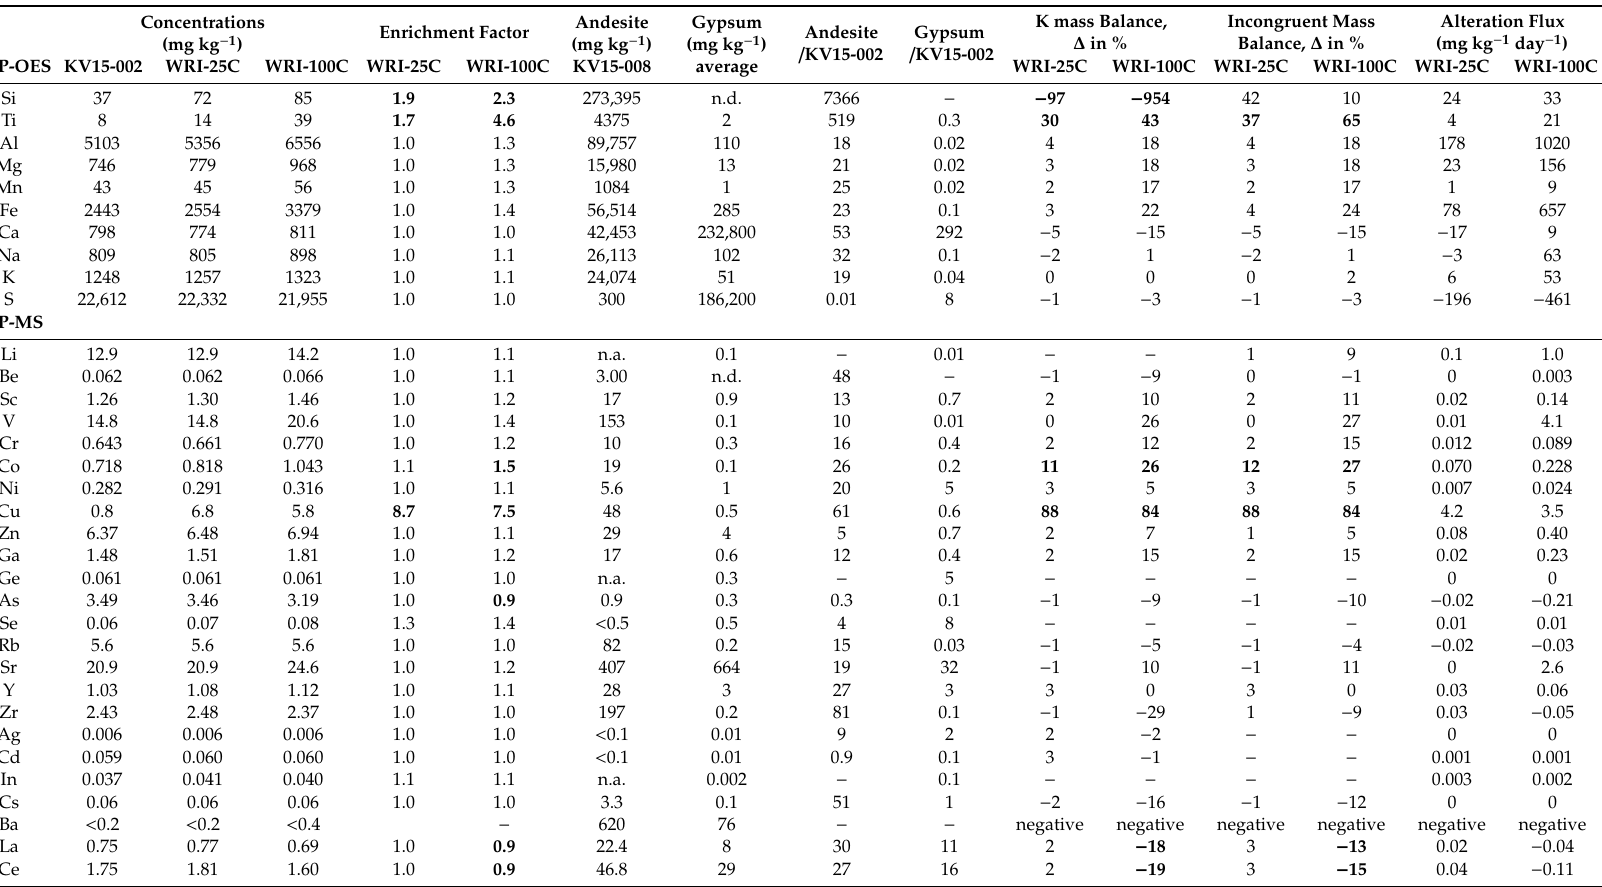
Table 2. Compositions of the starting and run product fluids as determined by ICP-OES and ICP-MS, the bulk composition of the starting andesite and the median composition of gypsum formed during Kawah Ijen quiescence (from [33]). Derived parameters include the enrichment factors of the experimental fluid, andesite and gypsum relative to the starting solution, results of mass balance calculations for congruous and incongruous andesite dissolution, and the calculated alteration mass flux (see the text for details on how these are calculated). Mass balance values and enrichment factors deviating from the general trend are highlighted in bold. Data are given in mg kg − 1 (n.d.—not detected, n.a.—not analysed, − means negative